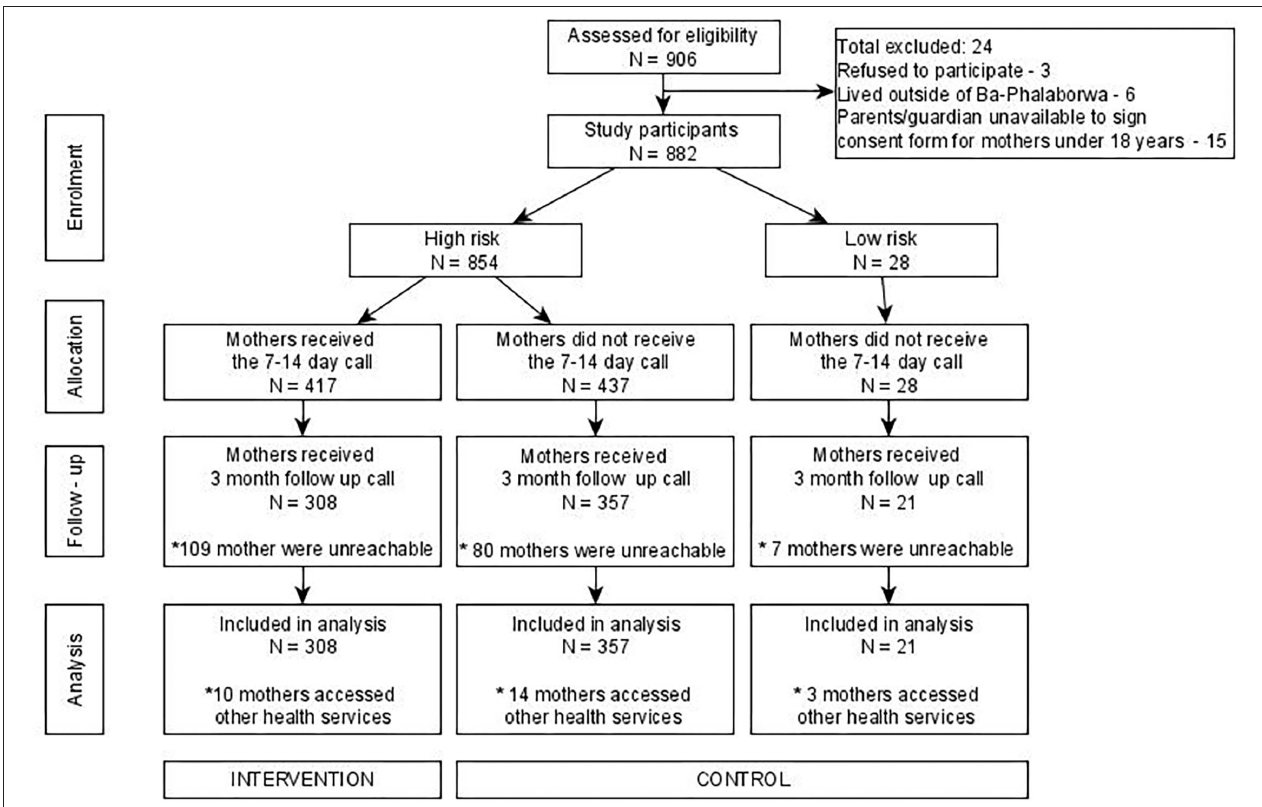
FIGURE 2 | Study flow